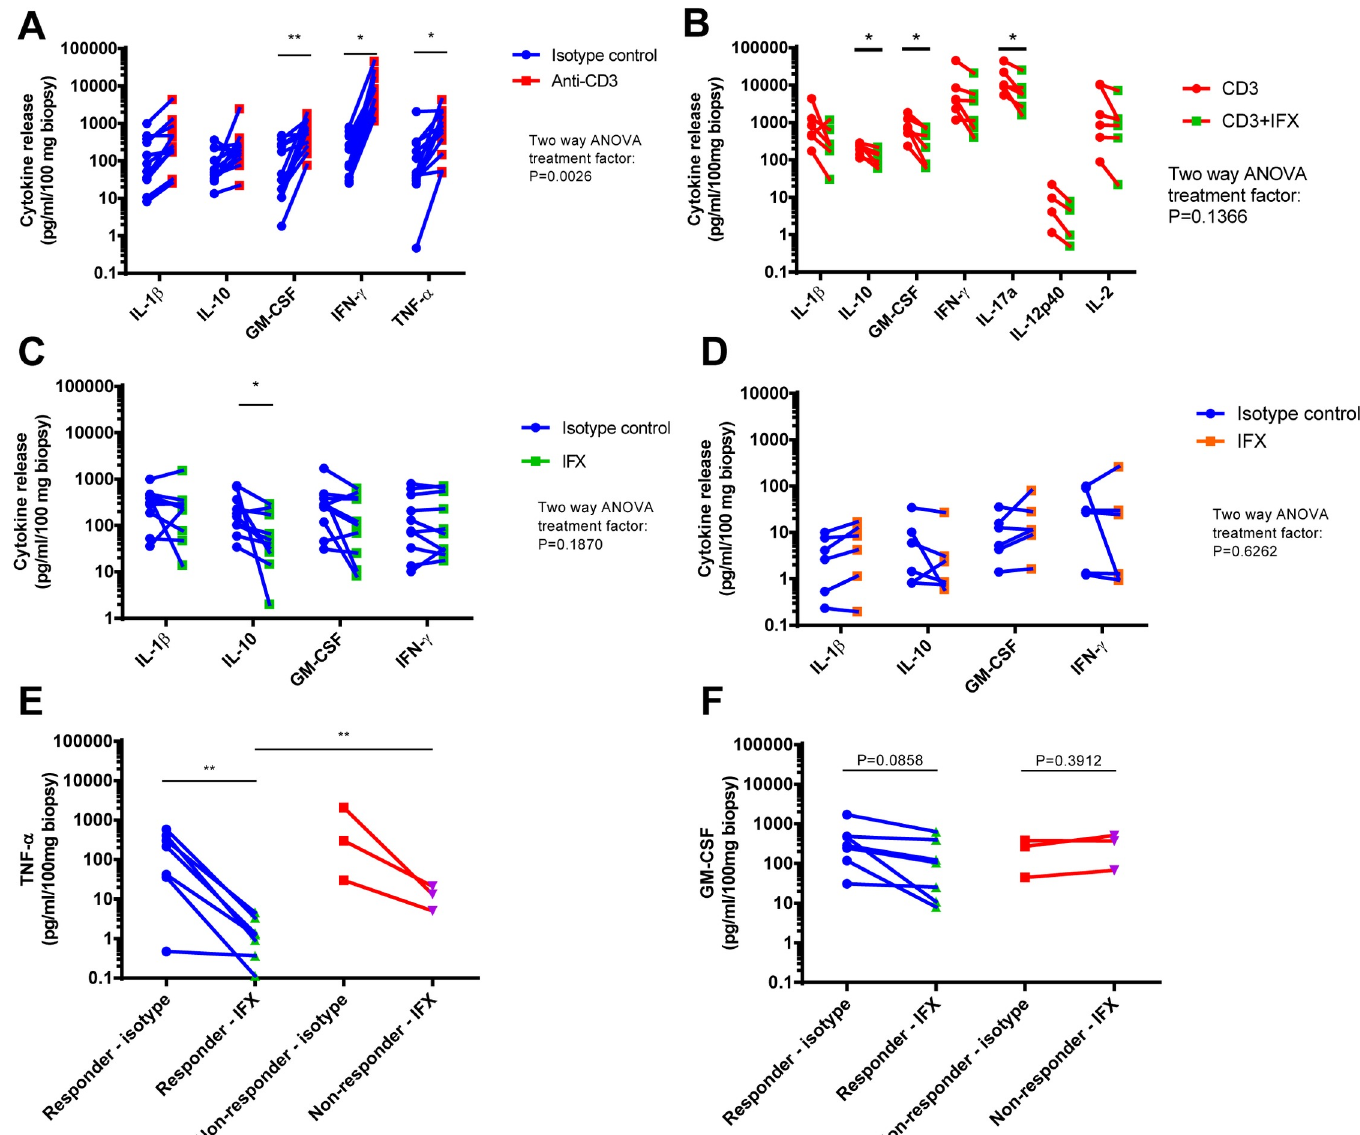
Fig 5. The assay responds to stimulation of the T cells and to a known biologic. (A) Cytokine release from inflamed colonic biopsies incubated with either anti-CD3 (10 μ g/ml) or isotype control (10 μ g/ml) in the explant assay for 24 hours (n = 12 patients, 2 – 4 biopsies each). Significant differences are observed for GM-CSF, IFN- γ and TNF- α (paired t-test) as well as across the panel, P = .0026 (two-way ANOVA). (B) Cytokine release from inflamed colonic biopsies cultured in the presence of 10 μ g/ml isotype control or 10 μ g/ml IFX activated by 10 μ g/ml anti-CD3 for 24 hours (n = 6 patients, 4 biopsies each). IL- 17a, IL-12p40 and IL-2 now reaches detection threshold under anti-CD3 stimulation. IL-10, GM-CSF and IL-17a release were significantly decreased by IFX treatment in the activated test (paired t-test). (C) Cytokine release from inflamed colonic biopsies cultured in the presence of 10 μ g/ml Infliximab (IFX) or isotype control for 24 hours (n = 10 patients, 2 – 4 biopsies each). IL-10 release was significantly decreased by IFX treatment (paired t-test). (D) Cytokine release from healthy colonic control biopsies cultured in the presence of 10 µ g/ml Infliximab (IFX) or isotype control for 24 hours (n = 6 patients, 4 biopsies each). Of the patients in (C), three were non-responders (had no effect) to IFX. All 10 are showed here divided into responders (or untested) and non- responders for TNF- α release (E) and GM-CSF release (F) (paired t-test within a group and un-paired t-test between responders and non-responders). * P < .05, ** P <